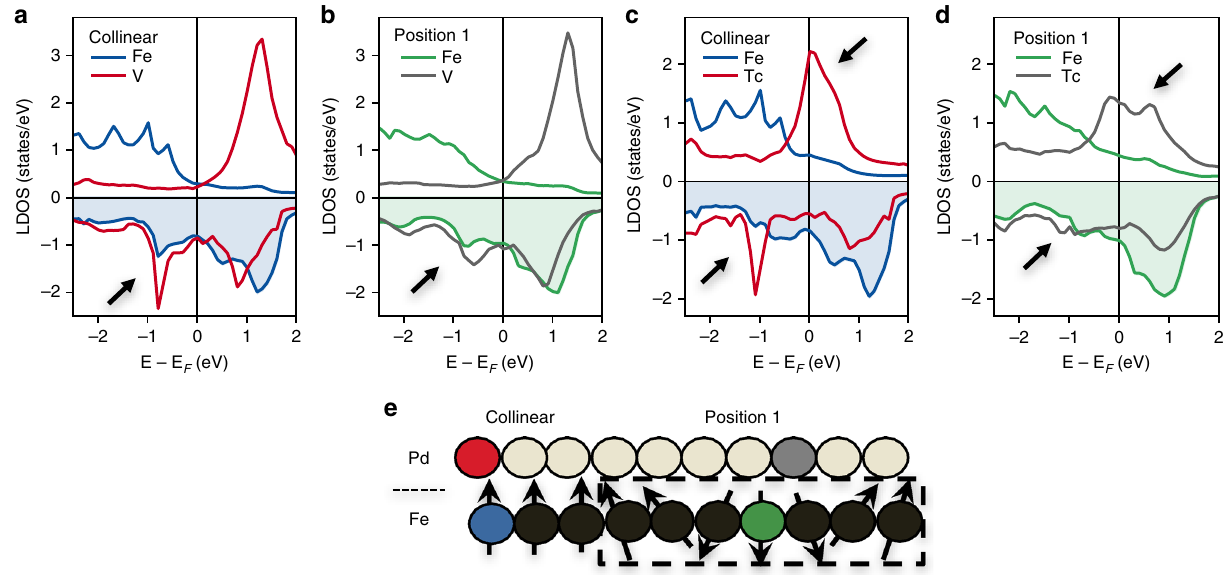
Fig. 3 Impact of magnetic environment on the impurities electronic structure. a , b The local density of states (LDOS) of V-inatom, the most skyrmion repelling impurity, as obtained when located within the collinear region (red lines in a ) or close to the skyrmion core (gray lines in b ). c , d Analogously for the most attracting impurity, Tc-inatom. For comparison, the LDOS of one of the closest Fe atoms to the impurity is plotted. Green corresponds to the skyrmion-case whereas blue to the ferromagnetic background. e Illustration of atom position corresponding to color code used in a –